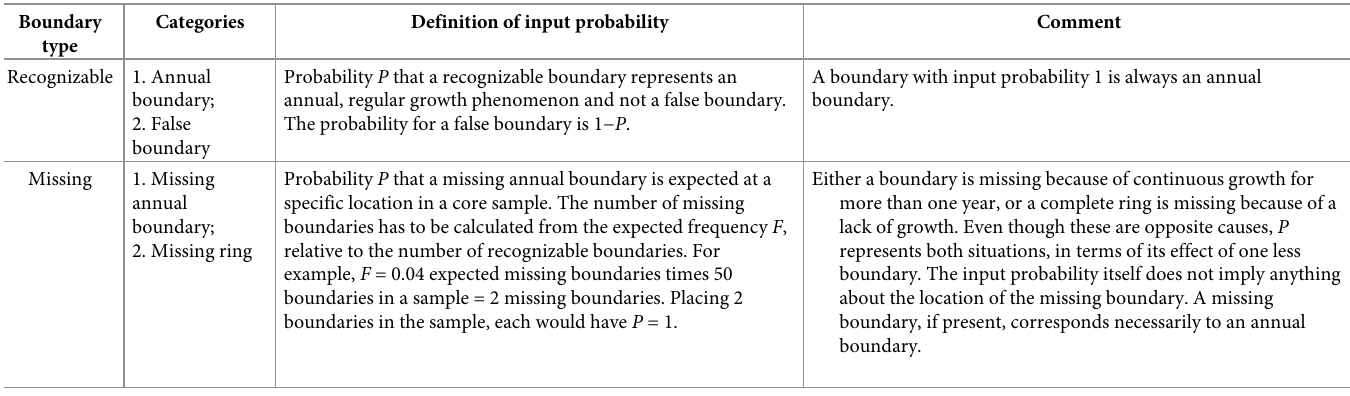
Table 1. Types of growth ring boundaries for assigning probabilities (0 < P � 1).